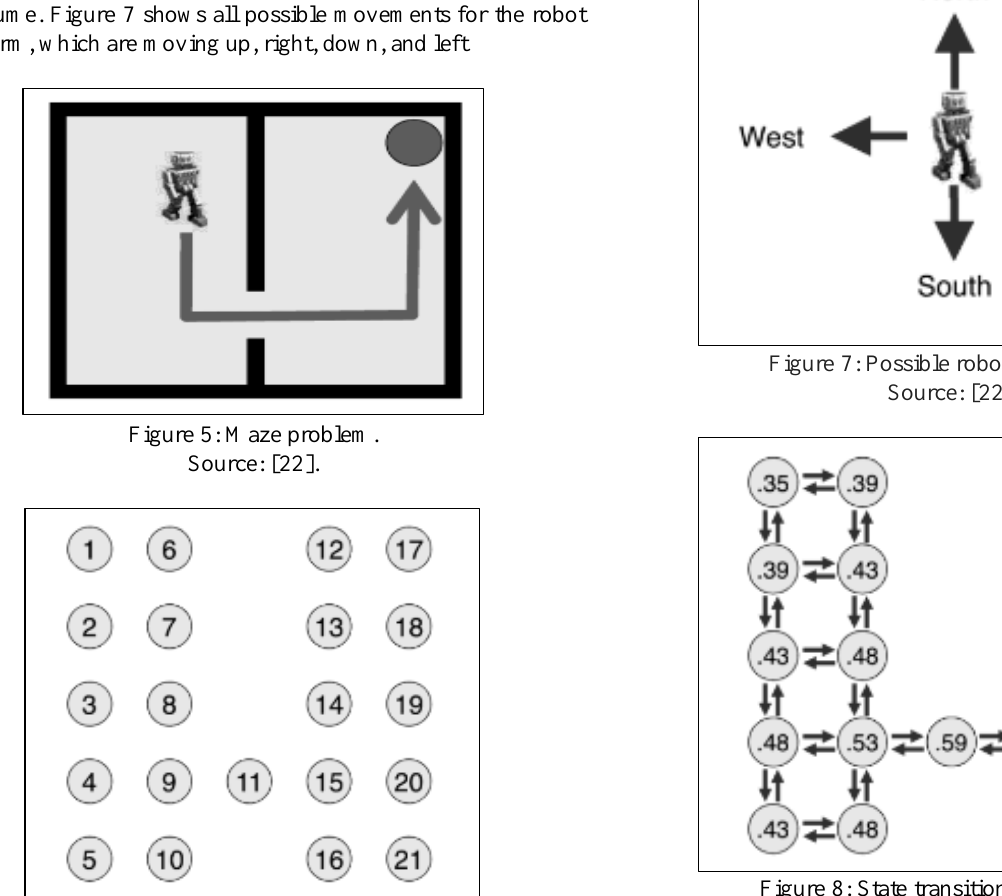
Figure 8: State transitions and rewards Source: